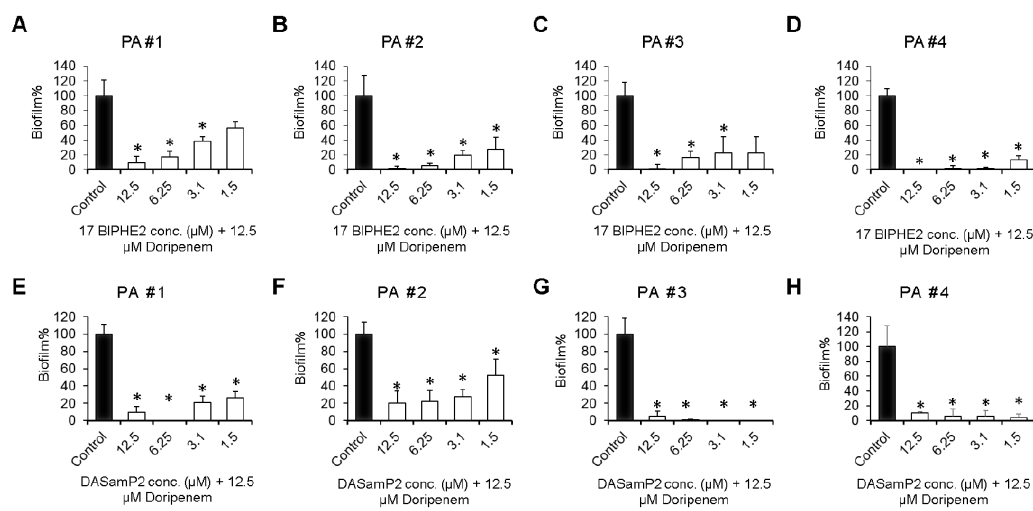
Figure 5. Disruption of the mature biofilms (24 h) of the P. aeruginosa clinical isolates with a combination of 17BIPHE2 (or DASamP2) and doripenem. Panels A – D represent combination treatment of 17BIPHE2 and doripenem against four different clinical isolates while panels E – H represent combinations between DASamP2 and doripenem against the same four clinical strains (strain #1, panels A and E ; strain #2, panels B and F ; strain #3, panels C and G ; and strain #4, panels D and H ). p values were calculated based on paired Student’s t -test with two tailed distribution and values <0.05 were considered significant (*).